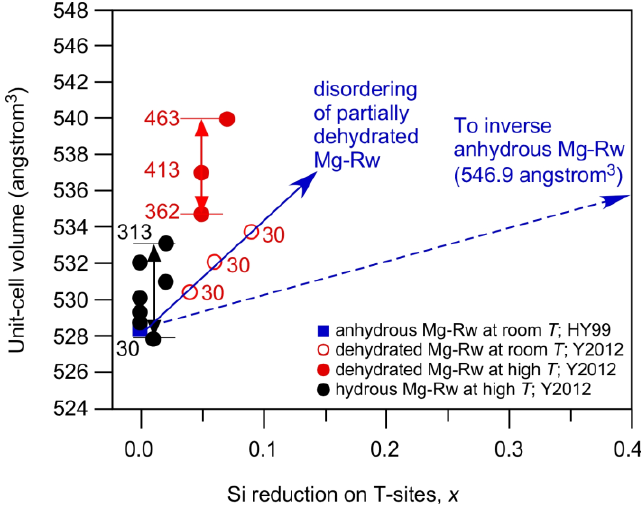
Figure 15. Effects of cation disorder on unit-cell volume and thermal expansivity of Mg-Rw. HY99, Hazen and Yang [8]; Y2012, Ye et al. [23]. The numbers along the symbols represent the T (in °C) for the single-crystal X-ray diffraction measurements. The size of the used crystal (SZ0820) was ~100 × 85 × 70 μm 3 , and the initial C H2O was about 1.77%. The X -ray data-collecting time at very T was ~4 h.